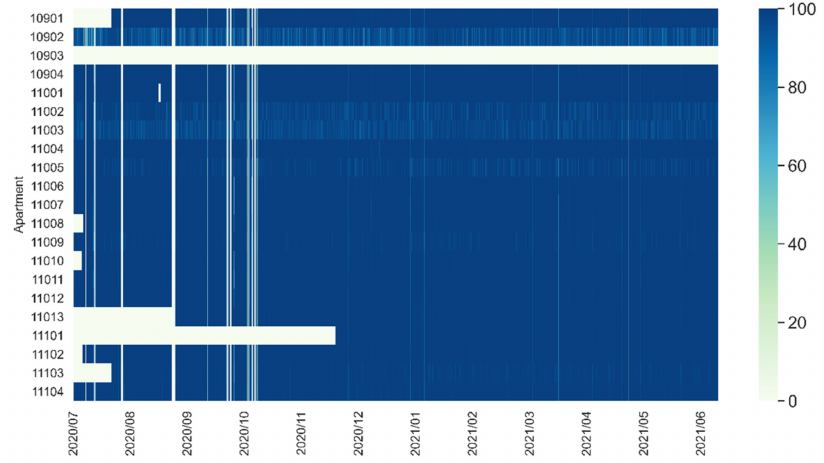
Figure 6. Hourly MDPR of indoor temperature for a subset of